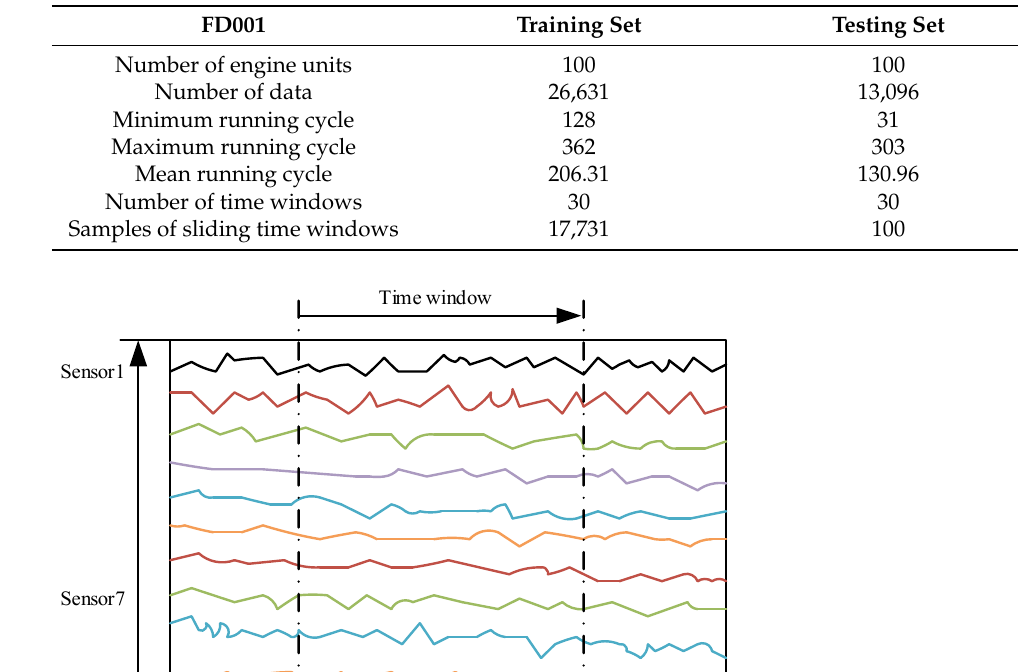
Table 3. FD001 dataset.